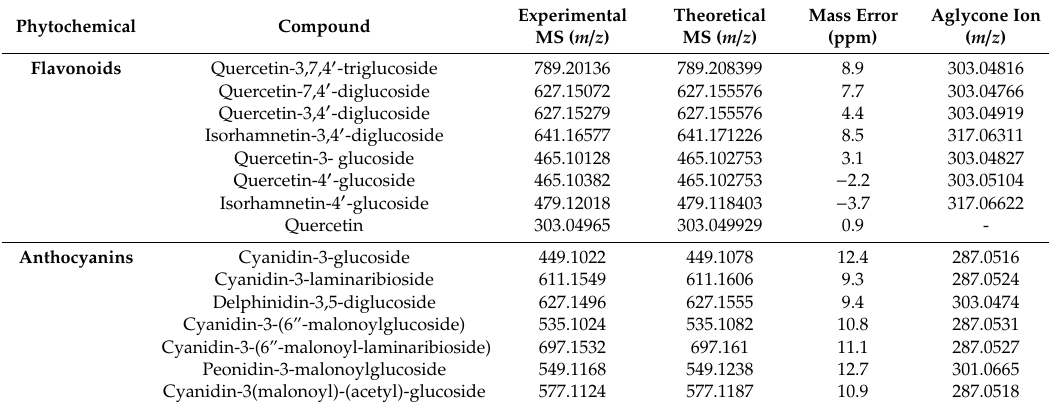
Table 2. Identification of flavonoids and anthocyanins in red onions by LC-ESI-QTOF-MS using the positive-ionization mode.